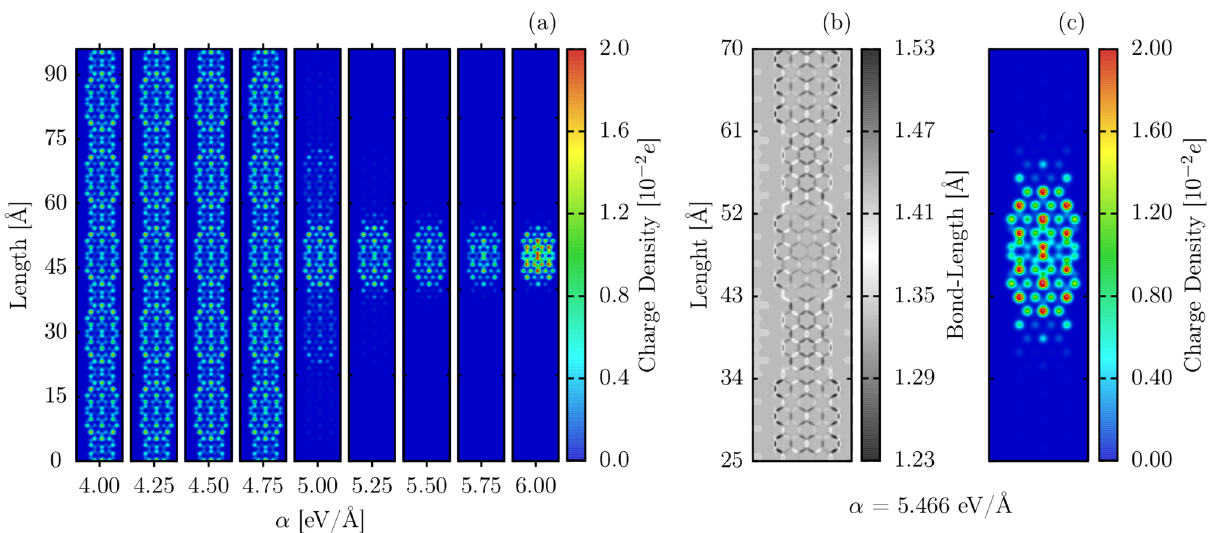
Figure 3. Atomic charge distribution for different electron-phonon coupling intensities ( a ), extended view of the bond-length ( b ) and charge density ( c ) in the presence of a polaron and with α = 5.466 eV/Å. The fragment presented corresponds to the zoom in the region of charge concentration of the nanoribbon with 288 Å of